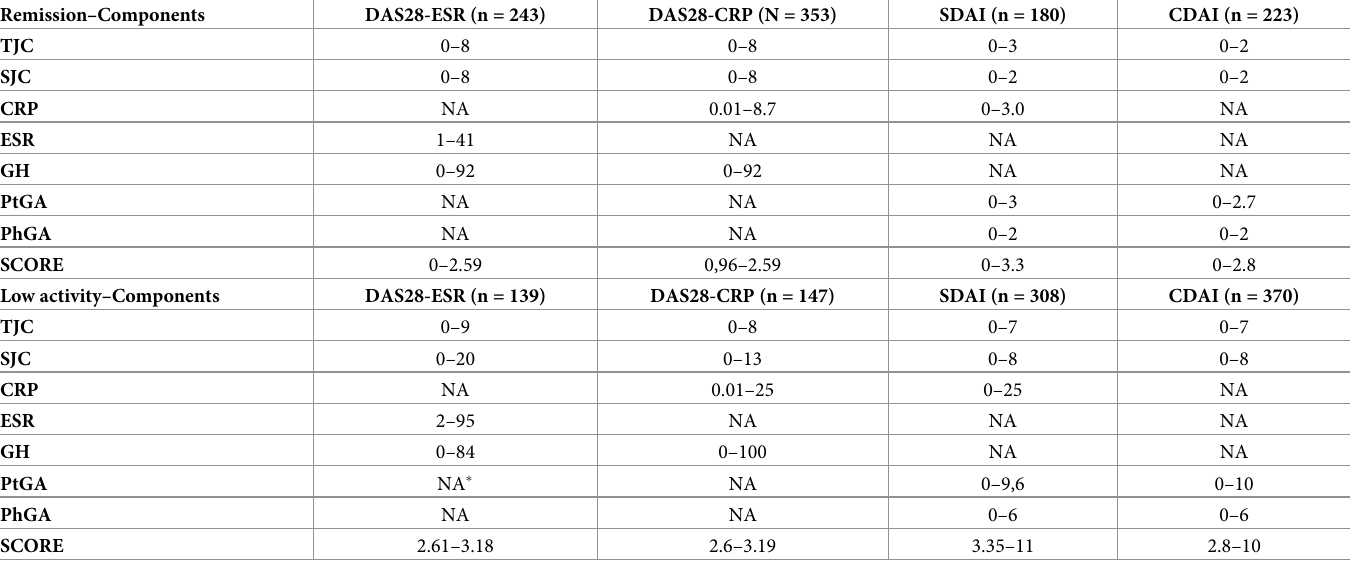
Table 7. Minimum and maximum values of components at remission and low